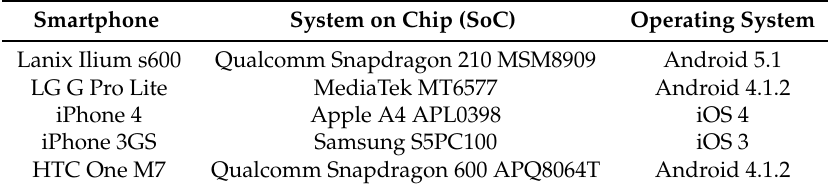
Table 2. Selected mobile phones system-on-chip and operating system.